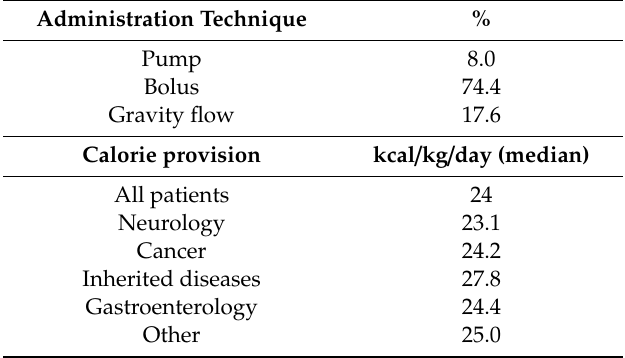
Table 3. Administration technique and energy provision.